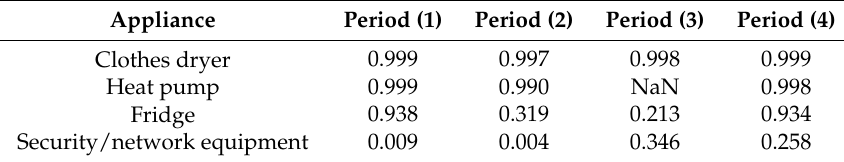
Table 4. R2 values from four periods for the four